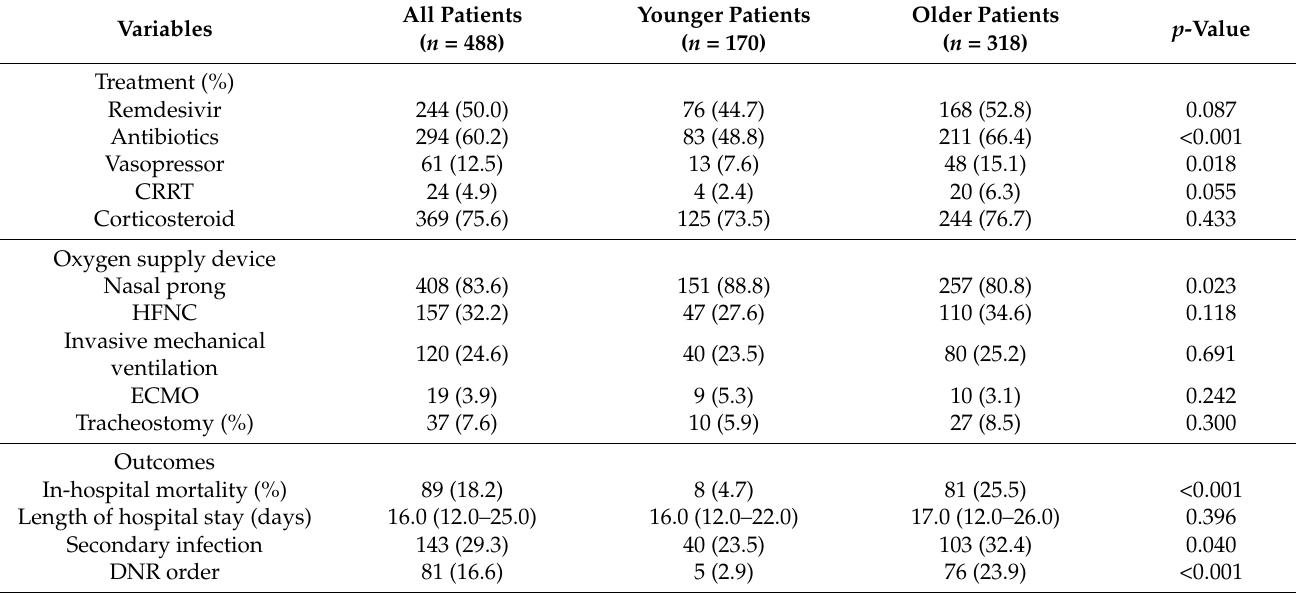
Table 2. Treatment and clinical outcomes of patients with severe COVID-19.